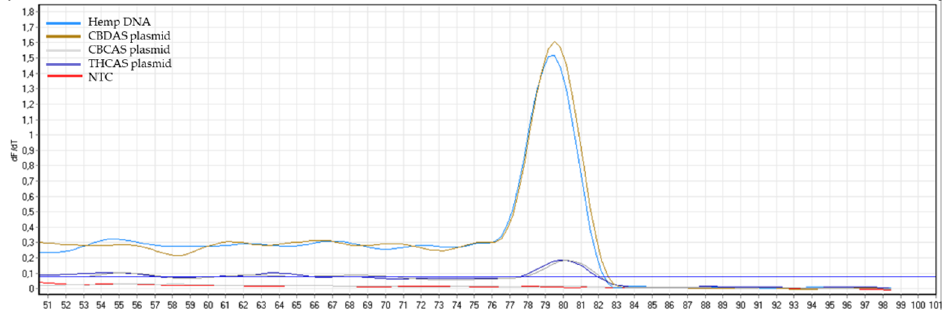
Figure A7. Melting curve plots, which display data collected during a melting curve and for nega- tive controls ( CBDAS plasmid and CBCAS plasmid).